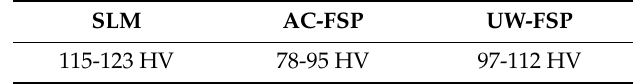
Table 1. Vickers micro-hardness values of SLM, AC-FSP and UW-FSP samples (HV 0.3).